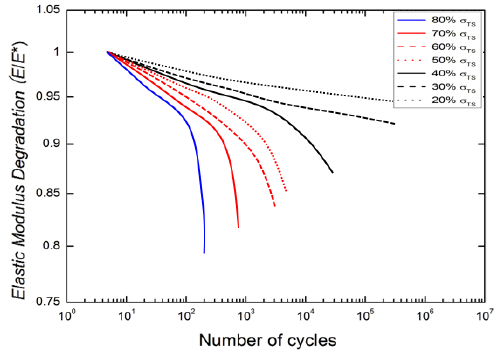
Figure 7. Change of elastic modulus in SMC composite subjected to different cyclic stresses during fatigue [3].